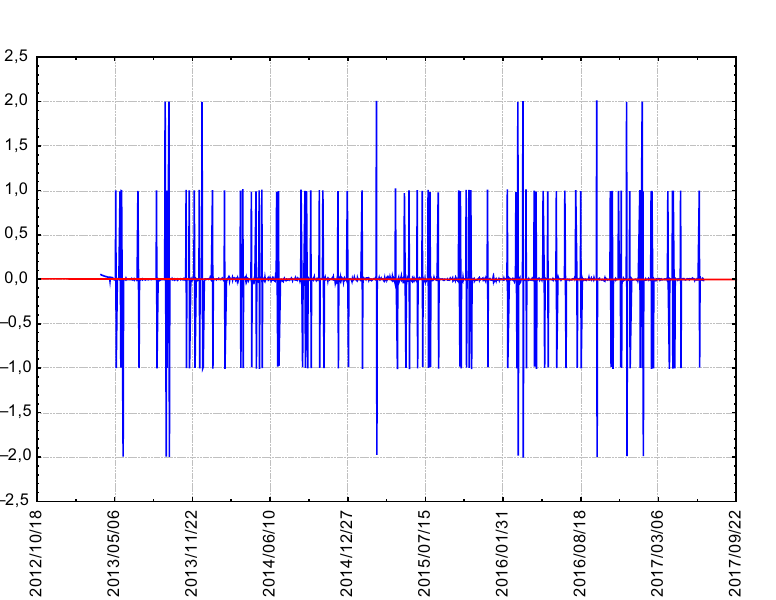
Figure 4. The conditional volatilities of the gasoline RBOB futures in the presence of OPEC news over the period from April 01, 2013 to